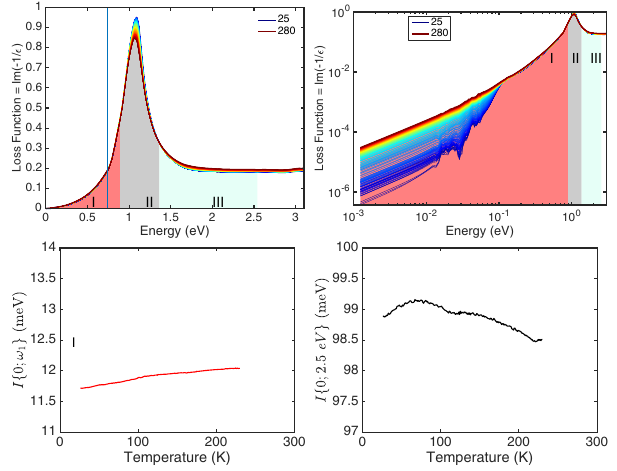
FIG. 20. Bi2223 optimally doped with an extended low-energy region from Ref. [77].